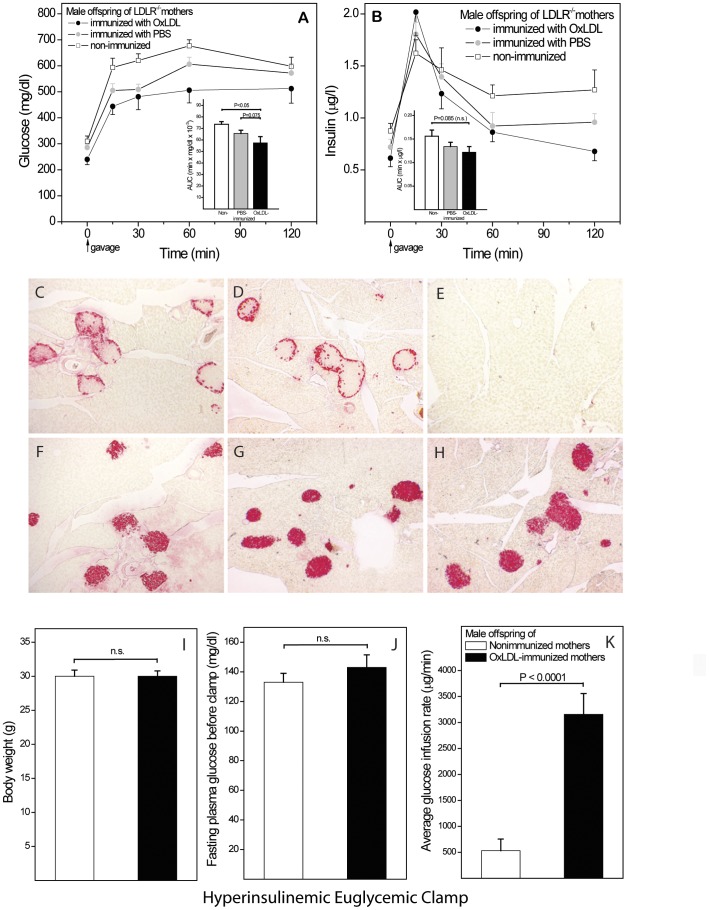
Protective effects of maternal OxLDL immunization in male offspring.(A,B) Glucose and insulin responses during an OGTT in male offspring of mothers immunized with OxLDL or PBS and non-immunized control mothers, after 28 weeks on 60% sucrose diet (n = 26). AUCs are shown as insets. (C–H) Pancreas immunohistochemistry of the same animals. Alpha cells identified by glucagon-staining in offspring of OxLDL-immunized (C) and control mothers (D). No-primary-antibody control (E). Beta cells staining for insulin in offspring of (F) OxLDL-immunized, (G) PBS-immunized and (H) control mothers (I–K). An additional group of male offspring of OxLDL-immunized and control mothers was fed sucrose for 38 weeks and then subjected to hyperinsulinemic euglycemic clamp (n = 16). Body weights (I) and fasting plasma glucose levels (J) were not significantly different, whereas the amounts of glucose infused during the euglycemic phase was markedly greater in offspring of OxLDL-immunized mothers (K).